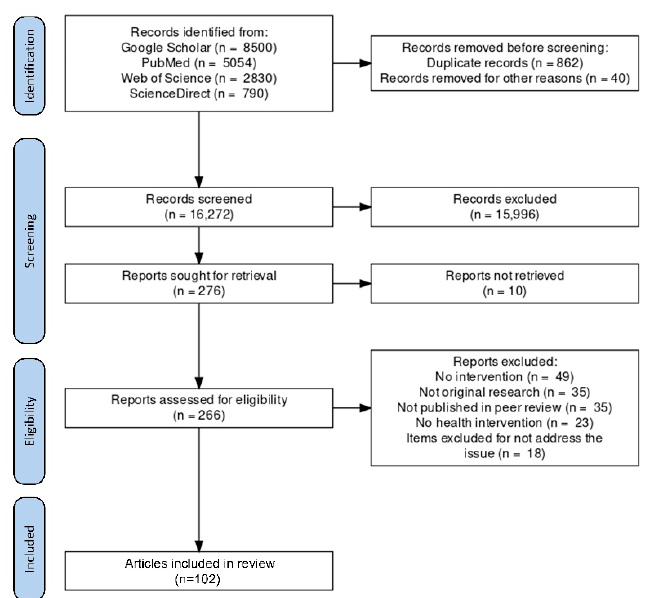
Figure 4. A PRISMA flow diagram for the article selection process is included in this review.